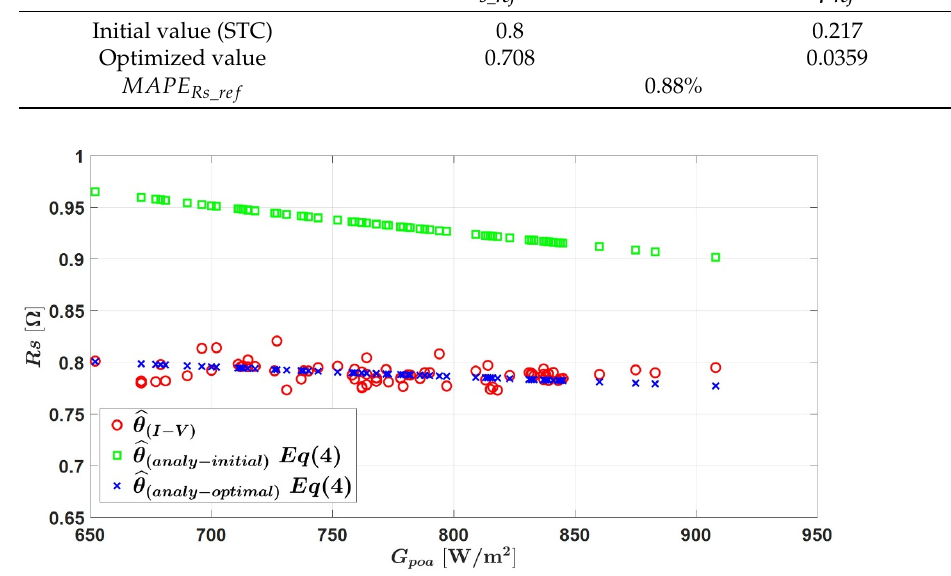
Figure 15. Evolution of R s for constant T pv .